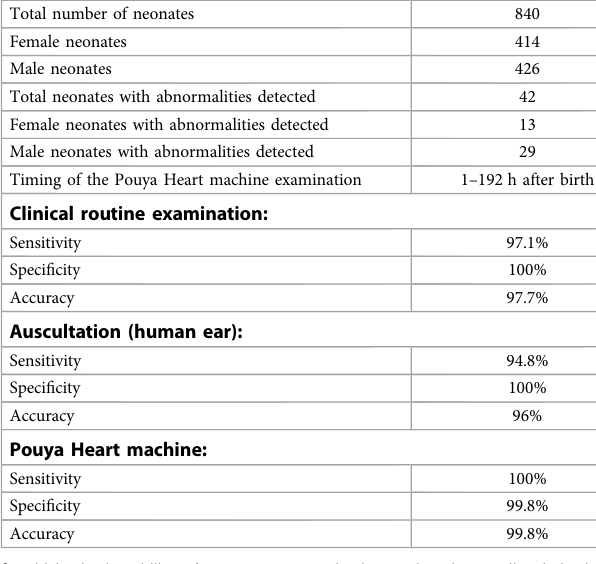
healthy patients. It is the proportion of true-positive and true-negative